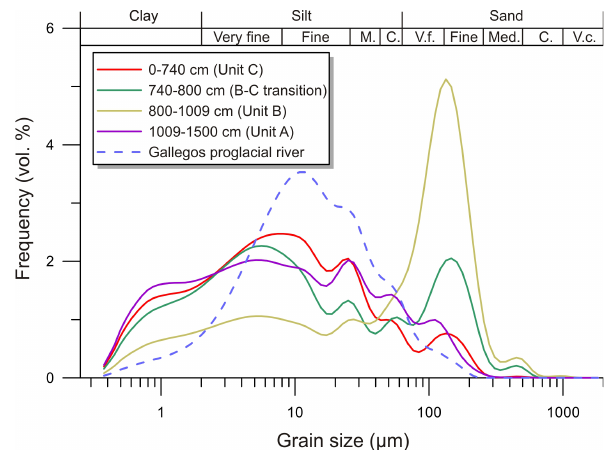
Fig. 7. Average grain size distributions of the main lithological units in core JPC14, compared to the grain size distribution of a sam- ple of suspended particles collected in the proglacial Gallegos river (Southern Patagonian Icefield, 54.513 ◦ S–69.871 ◦ W). The latter is representative of proglacial river sediments (Fenn and Gomez, 1989; Haritashya et al., 2010). The distributions demonstrate that lithological units A (1500–1009cm) and C (740–0cm) are typical of proglacial